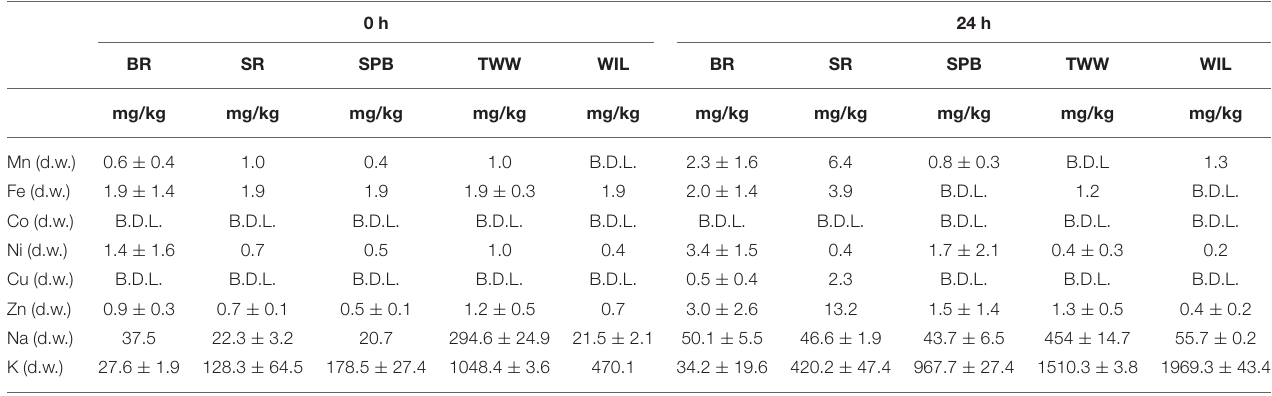
TABLE 4 | Trace element concentration within 24h of leaching from different biochar.